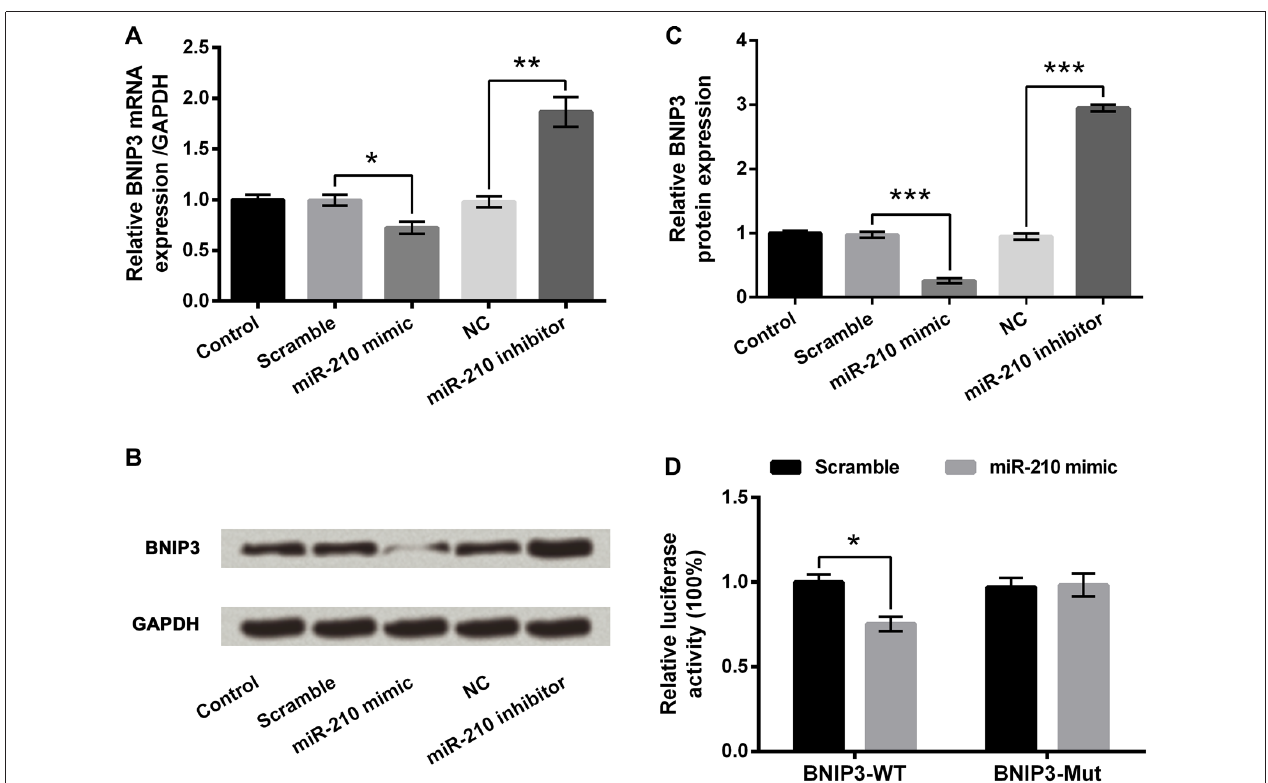
FIGURE 5 | BNIP3 is a target of miR-210. (A) mRNA expression of BNIP3. (B,C) Protein expression of BNIP3. (D) Dual luciferase reporter assay. Data presented are the mean ± SEM of at least three independent experiments. ∗ P < 0.05; ∗∗ P < 0.01; ∗∗∗ P < 0.001. BNIP3, Bcl-2 adenovirus E1B 19 kDa-interacting protein 3; NC, negative control of miR-210 inhibitor; BNIP3-WT, pMiR-report vector carrying wild-type BNIP3 3 (cid:48) -untranslated region (3 (cid:48) UTR) containing miR-210-binding sites; BNIP3-Mut, mutant